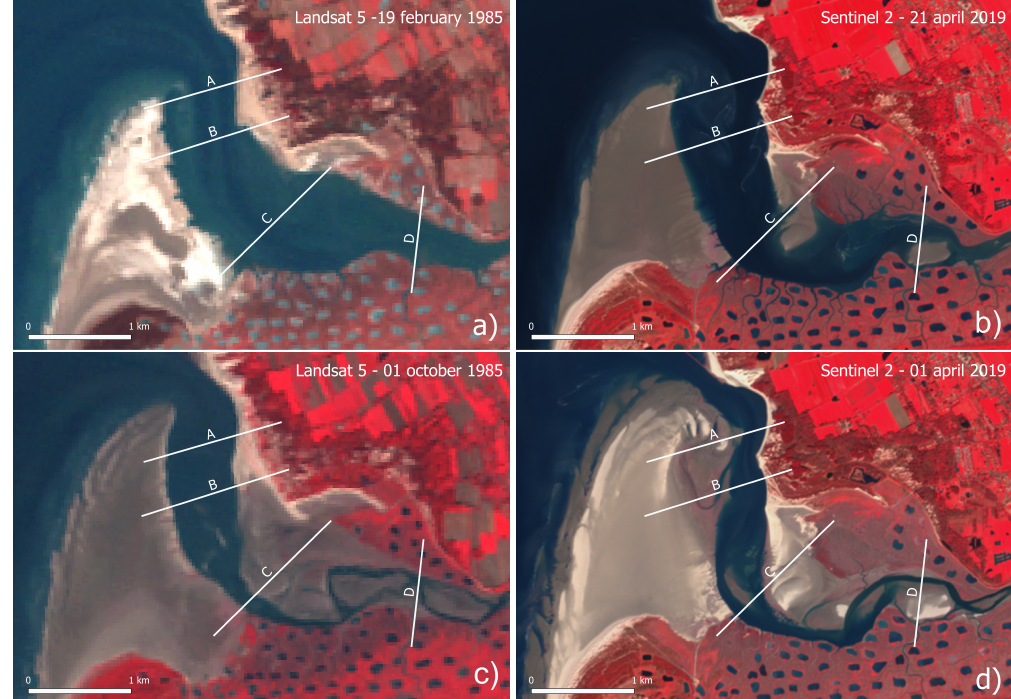
Figure 10. ( a , b ) Evolution of the upper Authie tidal basin from 1985 to 2019. The criterion for defining the upper basin is both the emerged spit platform and the submerged upstream bay. ( c , d ) Evolution of the lower Authie tidal basin from 1985 to 2019. The criterion for defining the lower basin is both the emerged spit platform and the emerged upstream bay. Chronicles of the minor river bed changes are recorded along transects A to